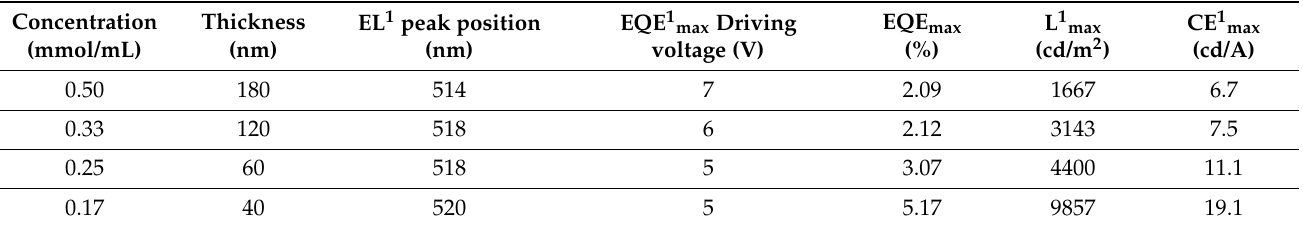
Table 1. Device performance of the PeLEDs made from different concentrations of the perovskite precursor